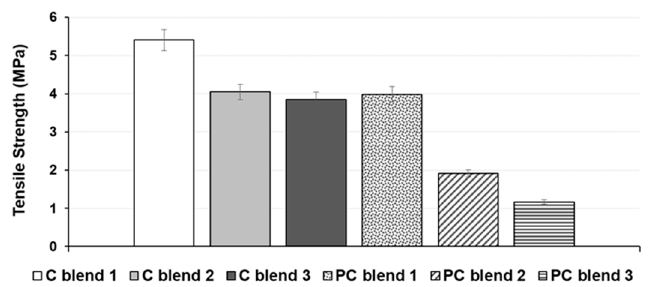
Figure 7. Tensile strength of bio-composite blends of cotton and polycotton.